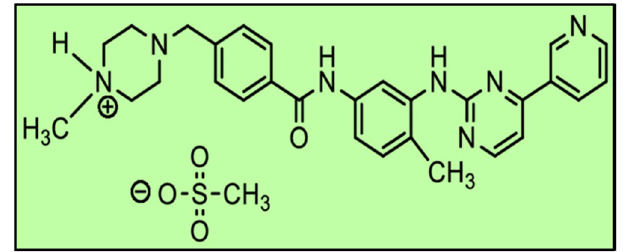
Figure 1. Chemical structure of Imatinib